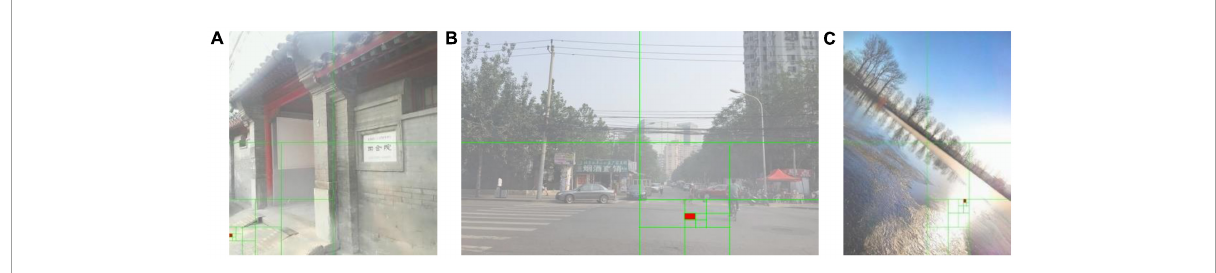
FIGURE3 Estimation of global atmospheric light using quadtree segmentation algorithm.